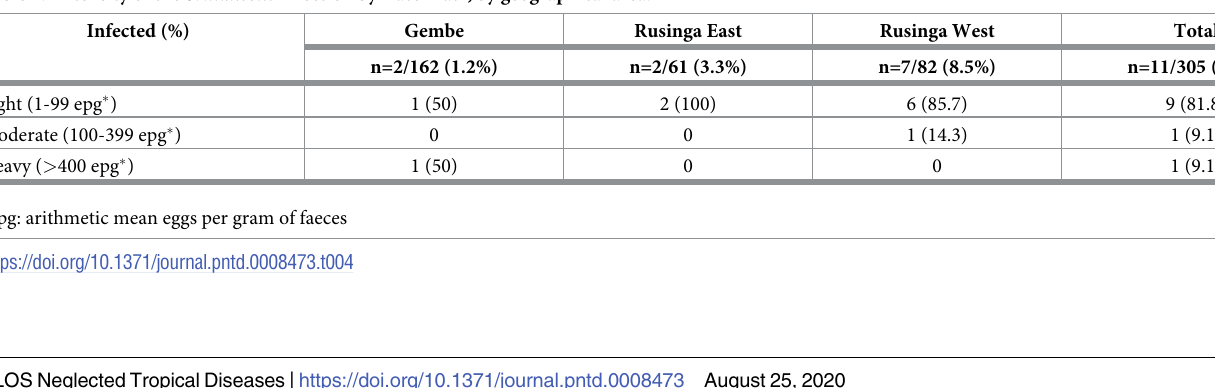
Table 4. Intensity of the S . mansoni infection by Kato-Katz, by geographical